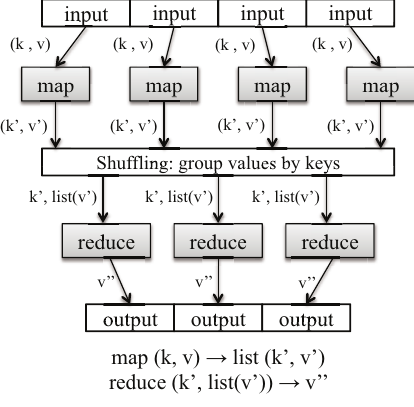
Fig. 1. The MapReduce programming